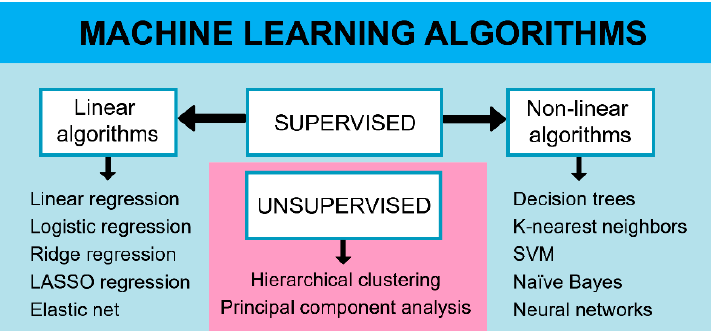
Figure 2. Classification of machine learning algorithms used in IBD research; LASSO—least absolute shrinkage and selection operator; SVM—support vector machines.